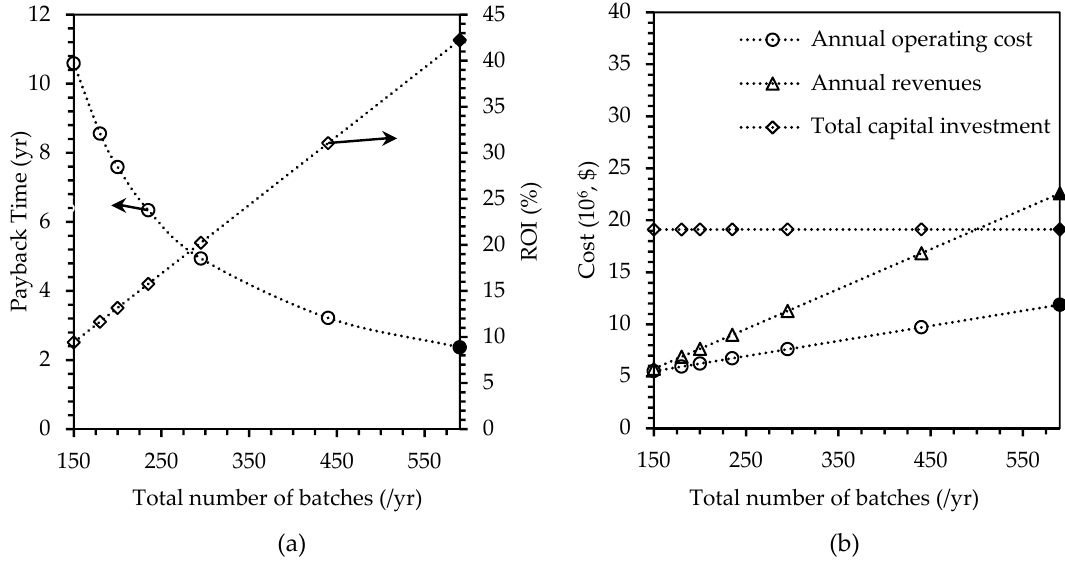
Figure 4. Effects of changing number of batches per year, on ( a ) payback time in years and return on investment (ROI) in percent, and ( b ) annual operating cost, annual revenues, and total capital investment in U.S. dollars. Filled markers represent results of the base case scenario.